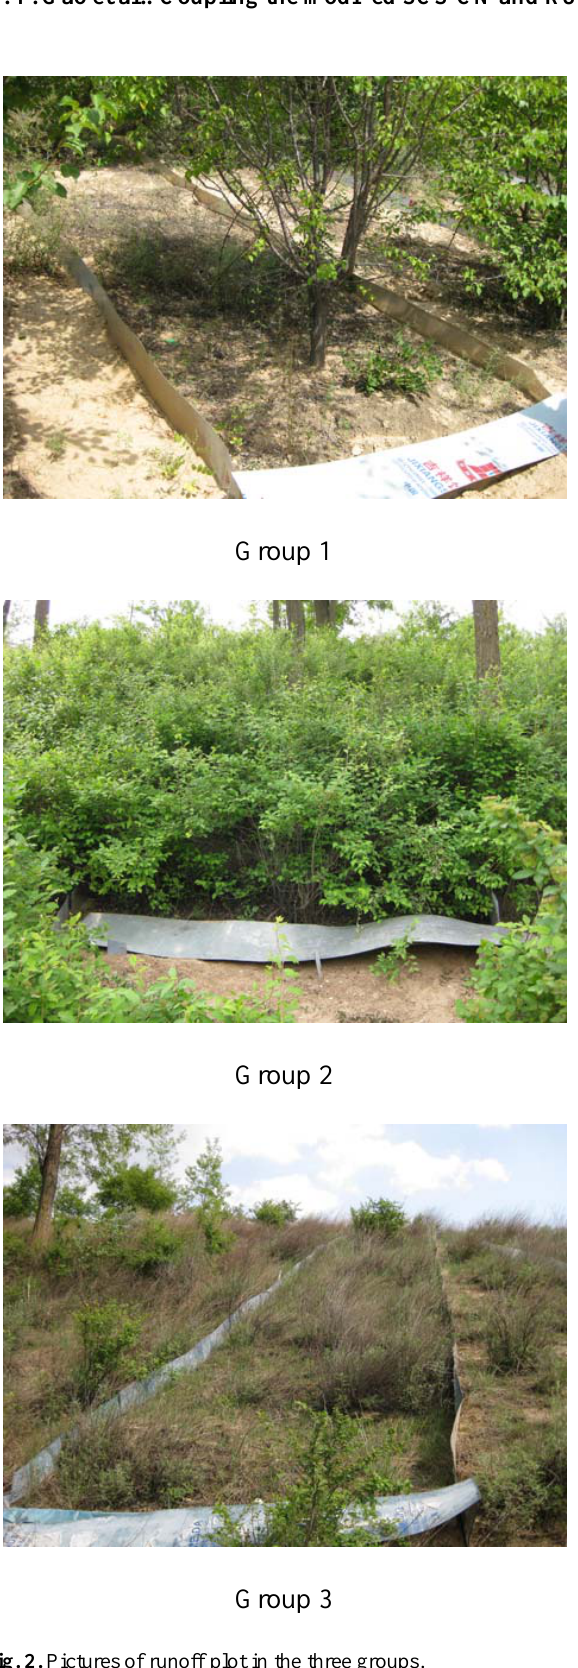
Fig. 2. Pictures of runoff plot in the three groups